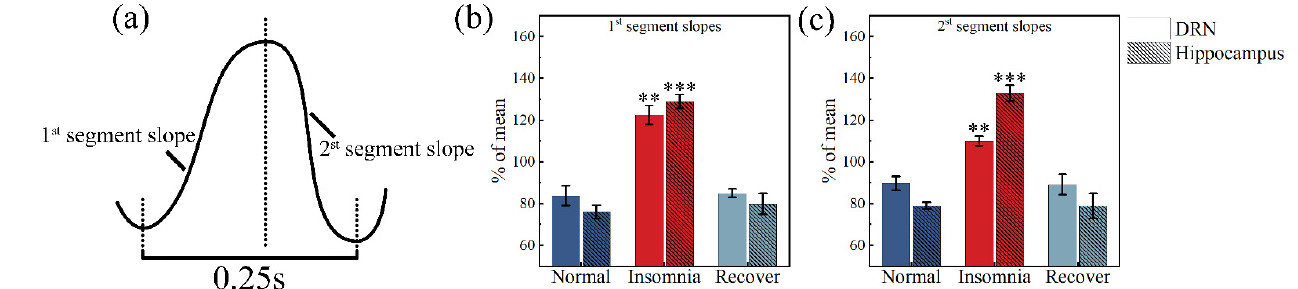
Figure 9. Calculations and analysis of δ wave slope in rats’ dorsal raphe nucleus (DRN) and hippo- campus in normal, insomnia and recovery states ( n = 12). ( a ) Representative individual LFP δ wave; ( b ) first segment slopes in the DRN and hippocampus. ( c ) Second segment slopes in the DRN and hippocampus. (** p < 0.01, *** p < 0.001, compared to normal in the same segment).